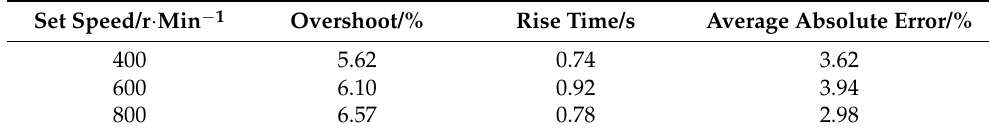
Table 9. Outdoor test